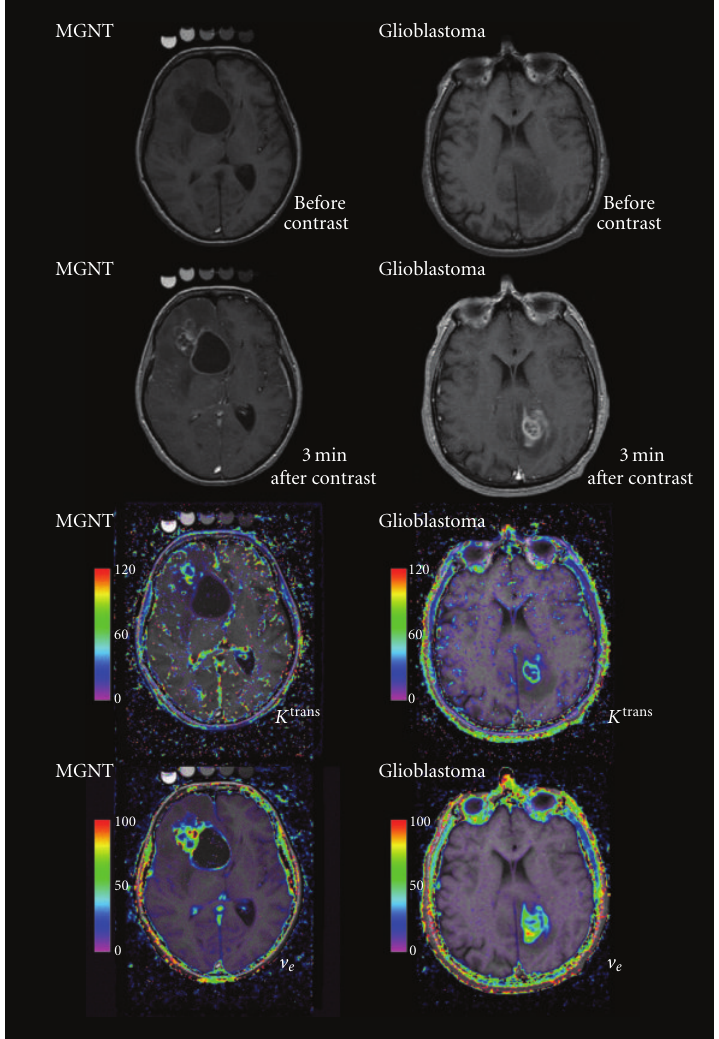
Figure 1: From top to bottom T1-weighted MR image before and 3min after contrast agent injection, calculated map of transfer constant ( K trans in min − 1 ) and of extracellular extravascular space fraction ( v e in %). An example of a malignant glioneuronal tumor is on the left and of a glioblastoma is on the right. The color code increases from purple to red. On the postcontrast T1 images the MGNT shows a complex structure, whereas the GBM sows a typical enhanced